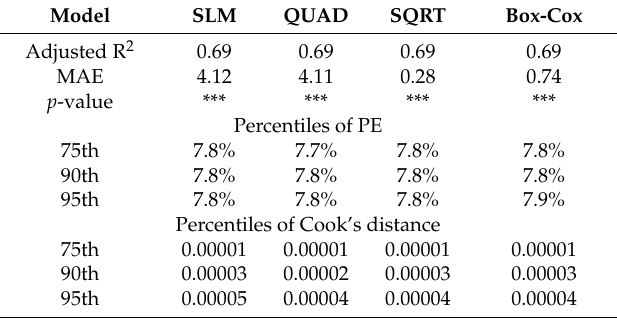
Table 3. Mean absolute error (MAE) and percent error (PE), adjusted R 2 and percentiles of Cook’s distance of the models (linear model (SLM), quadratic transformation (QUAD), Box-Cox transformation (Box-Cox) and square root transformation (SQRT)) for liveweight predictions on testing dataset. Model